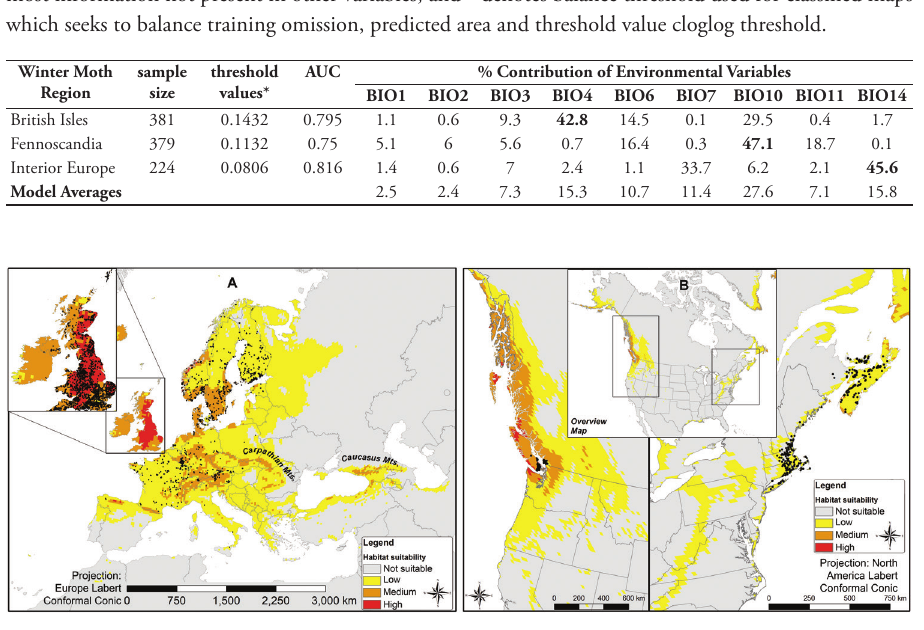
Figure 3. Predicted suitable habitat in native range (panel A ) and invaded range (panel B ) with occur- rence records (shown as black dots), this reclassified map is based on the averaged prediction for three spatial bins in the native range. Probabilities falling below balance threshold values shown in Table 2 for each of the three models were classified as “not suitable”. Probabilities < 0.25 were classified as “low suit- ability”, values > 0.25 but < 0.5 were classified as “medium suitability” and values > 0.5 were considered “high